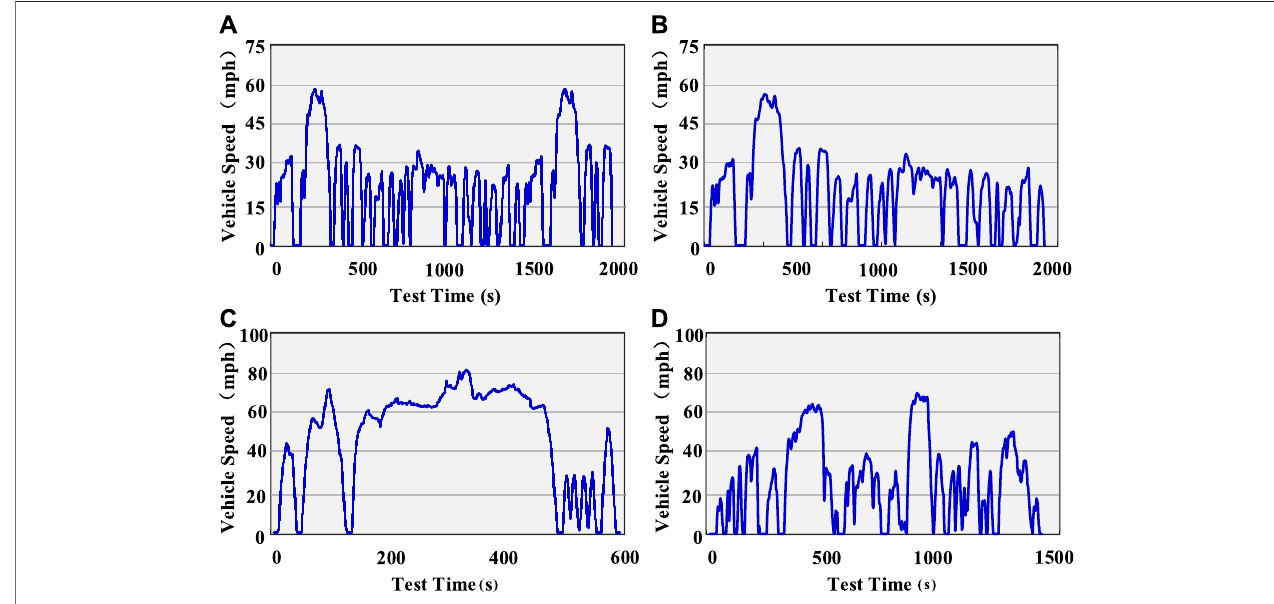
FIGURE 5 | Battery test loading pro fi les in INR 18650-20R dataset: (A) DST, (B) FUDS, (C) US06, and (D) BJDST.